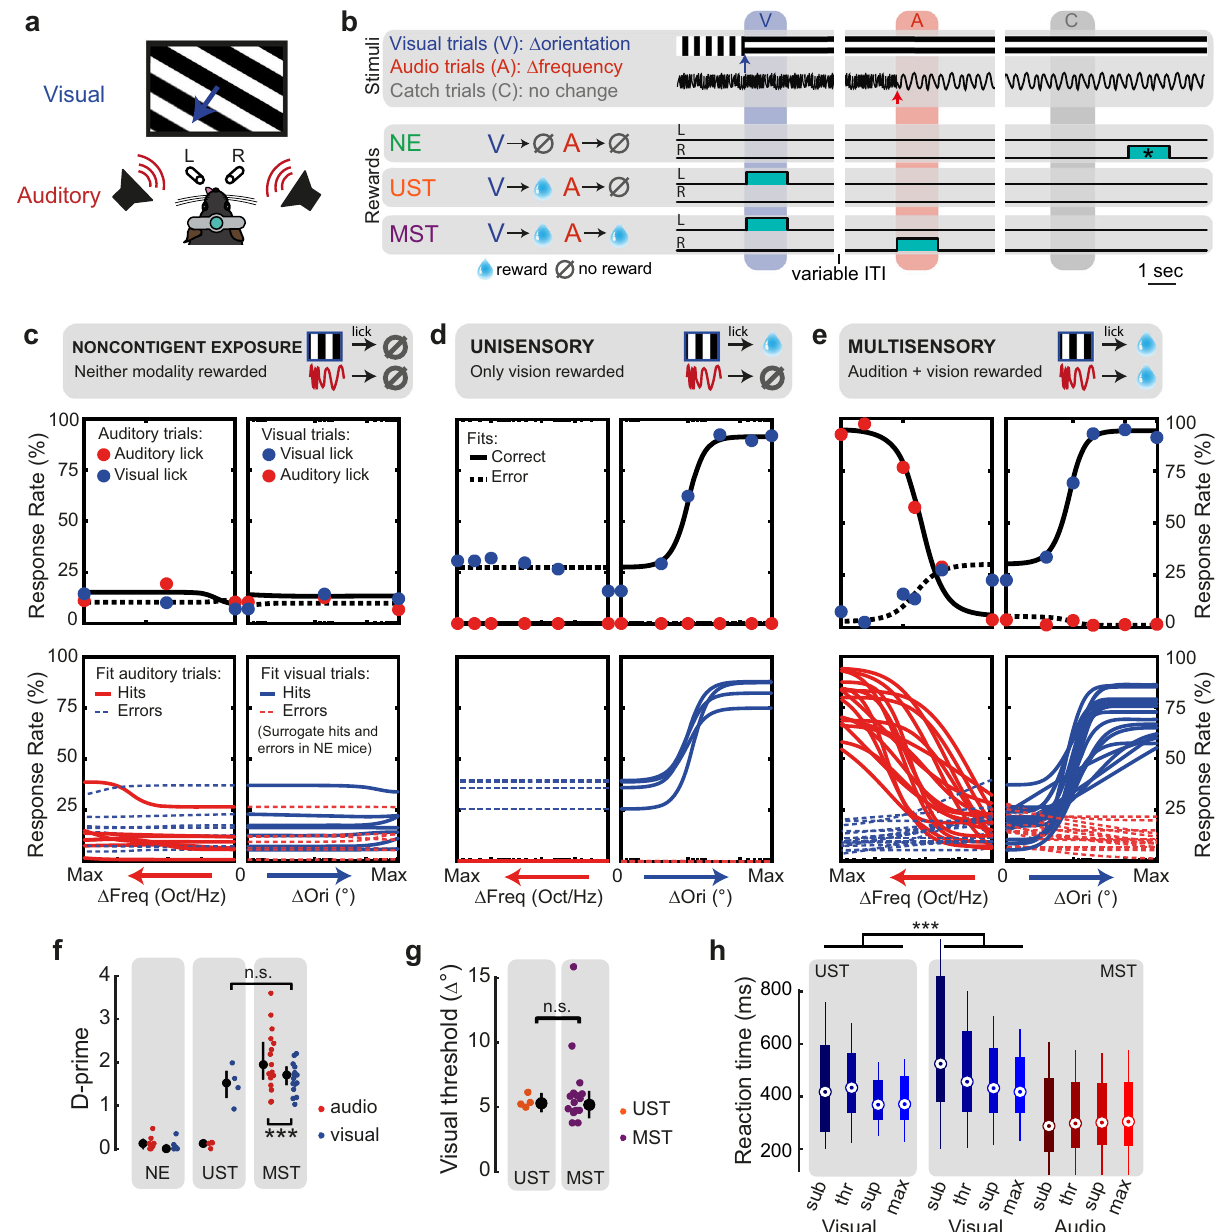
false alarms (Fig. 2d, e). These dynamics of early and late wave activity were seen for both threshold-level (thr) and maximal (max) orientation changes (Supplementary Fig. 3a, b). Splitting neurons based on recorded depth revealed different laminar dynamics. Early sensory-induced activity was most prominent in the granular and supragranular layers and was similar for hits and misses ( p > 0.05 for all laminar zones). During visual hits, late activity was prominent in supragranular and infragranular layers and was stronger than early activity (Fig. 2f). The late hit-related modulation (hits – misses, subtracted z-scored fi ring rate during 200 – 1000 ms) was stronger in supra- and infragranular layers than in the granular layer (F(2,771) = 4, p = 0.019, ANOVA; Posthoc comparison: IG vs G: F (1,784) = 12.97, p < 0.001; G vs SG: F (1,784) = 6.50, p = 0.01; IG vs SG: F (1,784) = 0.58, p = 0.45. This is consistent with the idea that the granular layer is more strongly driven by thalamocortical afferents and extragranular layers more by recurrent processing. We also classi fi ed